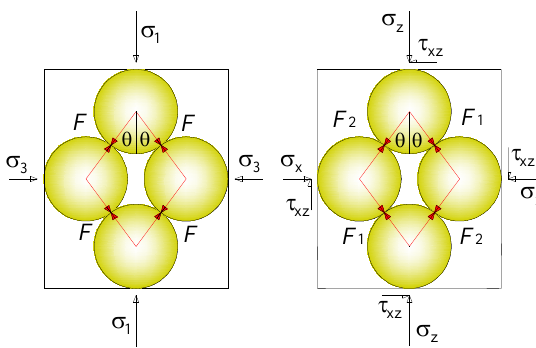
Fig. 1. R hombic packing of spheres and forces of contact induced by overall stresses in: a) coaxial packing, and b) partially coaxial packing.